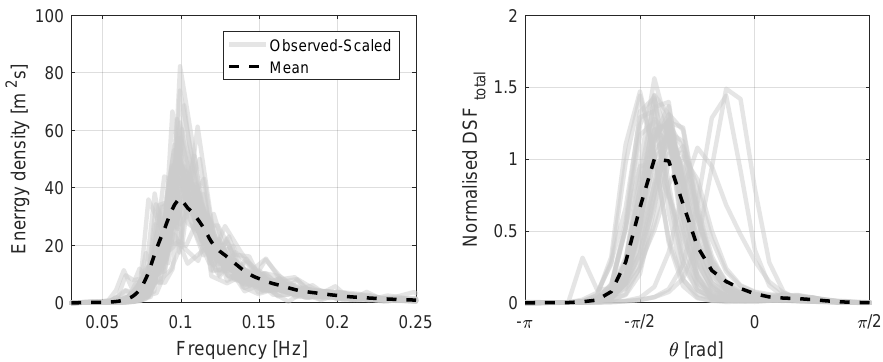
Figure 16. Variation in frequency spectra and DSF’s for low T E example case. 33 spectra from 11 storms shifted onto the desired H m 0 – T E target point 2 defined in Figure